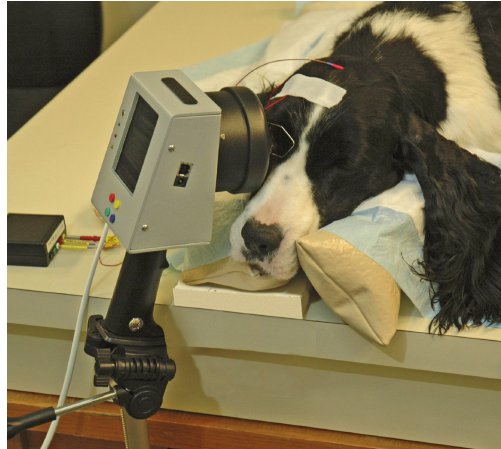
Figure 1: An English Springer Spaniel (ESS) dog deeply sedated and prepared for functional evaluation of the retina. The handheld multispecies electroretinograph (HMsERG) unit is used together with a preprogrammed protocol for evaluation of rod and cone